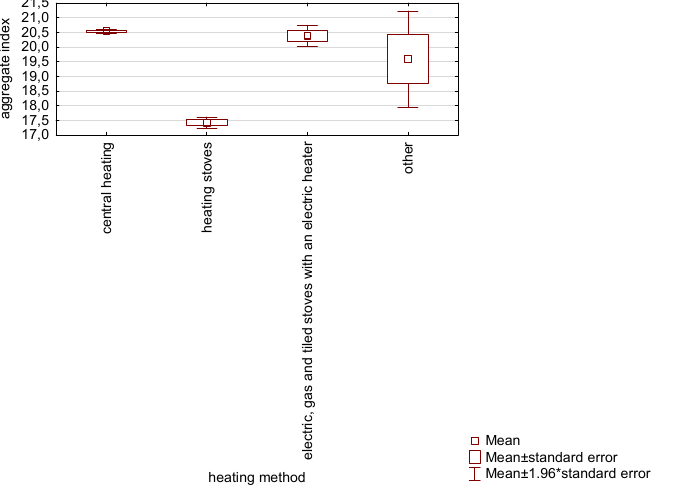
Mean±1.96*standard error